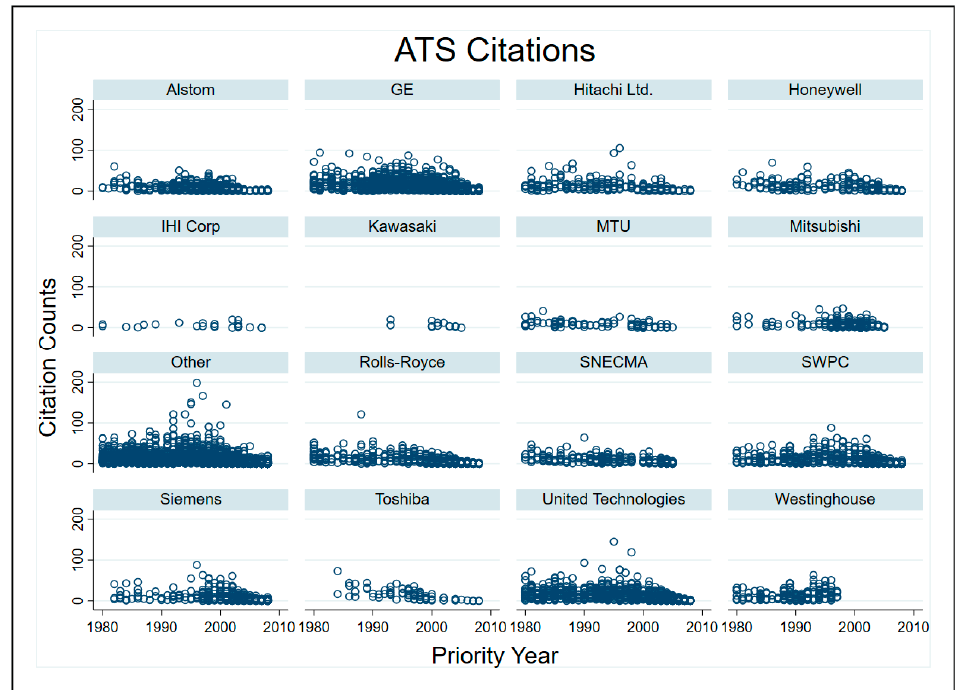
Figure 4. Citation counts for United States Patenting and Trademark Office (USPTO) ATS patents by each company using the search strategy described in this study (Section 4.1) with the PATSTAT database.